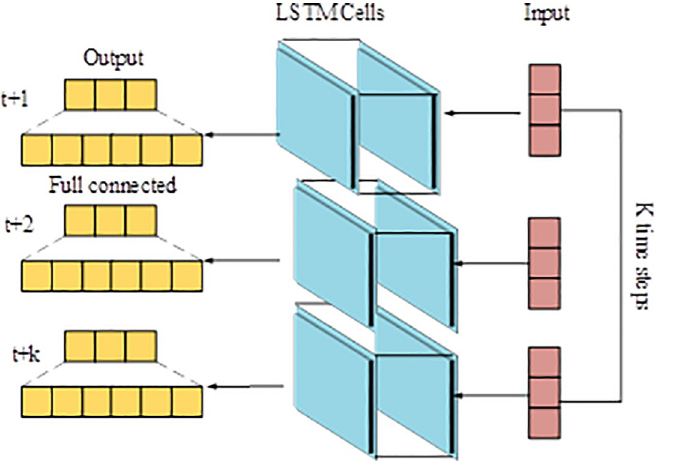
Fig 5. Structure of LSTM